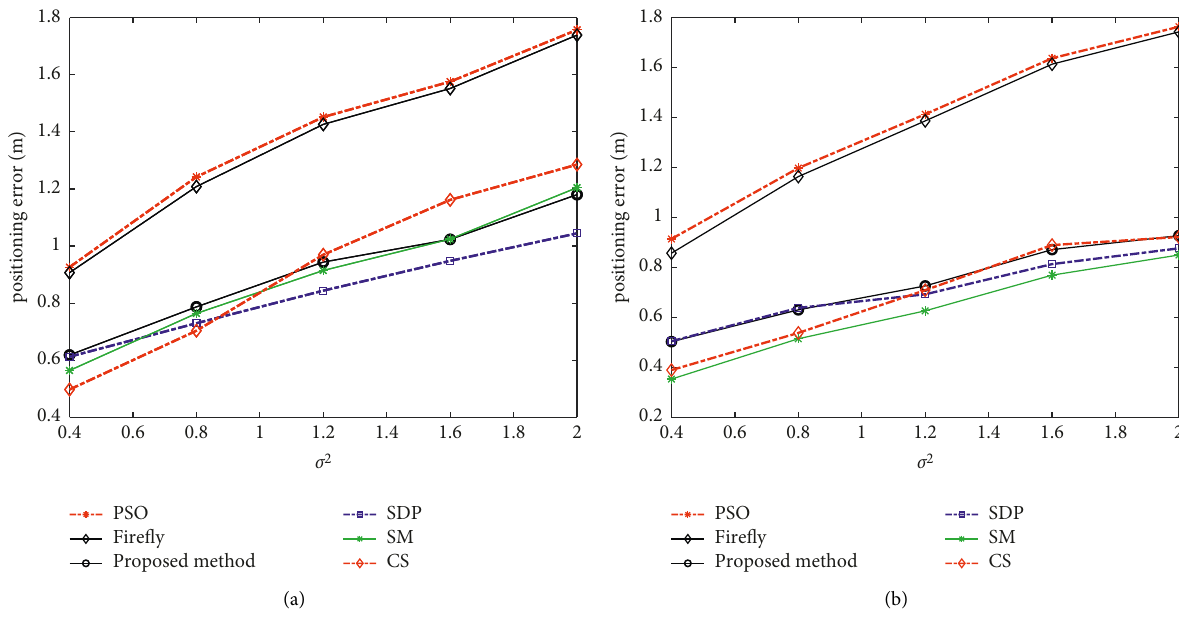
Figure 2: The variation of the positioning error with the variance of the ranging error. (a) I � 8, K � 4; (b) I � 16, K � 4.